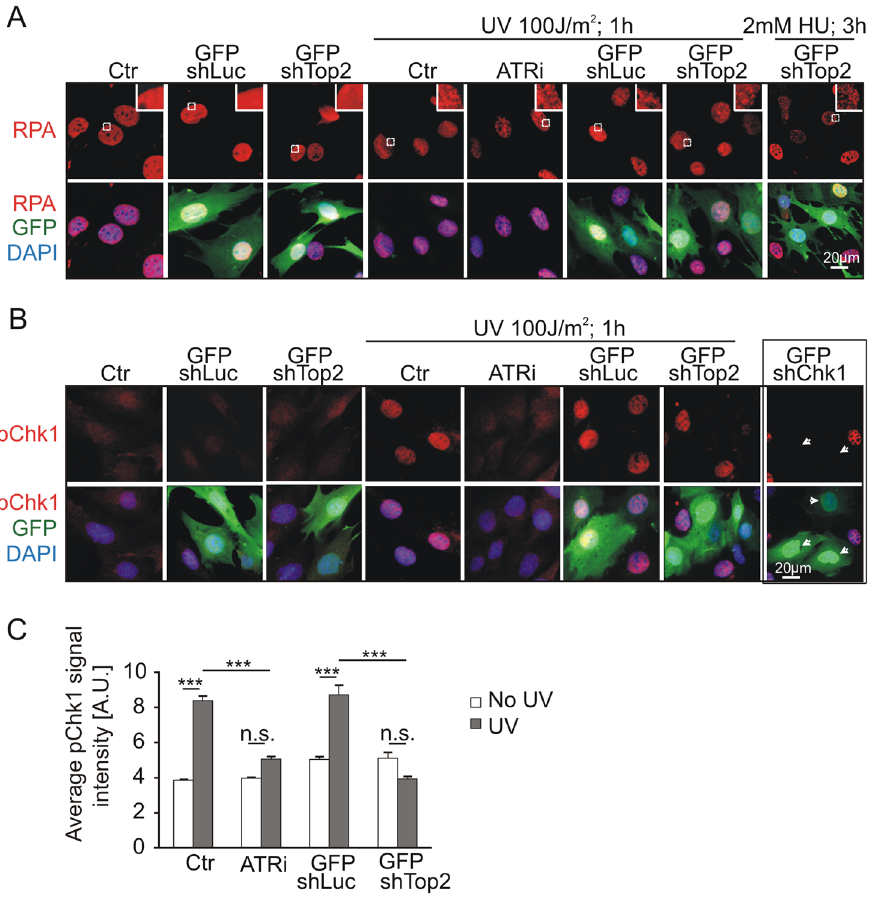
Figure 5. Mutation of AAD impairs ATR-Chk1 pathway invivo . ( A ) Immunostaining of RPA (red and upper panel) in TopBP1 ki/ + cells 36 hr after transfection with GFP-shLuc or GFP-shTop2 without or with the indicated treatment. ATRi, ATR inhibitor. GFP-shLuc or GFP-shTop2 transfection is visualized by GFP (green). DNA was stained with DAPI (blue). Inset shows the enlargement of selected areas. ( B ) Immunostaining of phosphorylation of Chk1-S317 (pChk1, red, upper panel) in TopBP1 ki/ + cells 36 hr after transfection with GFP-shLuc or GFP-shTop2 without or with the indicated treatment. ATRi, ATR inhibitor. GFP-shLuc or GFP-shTop2 transfection is visualized by GFP (green). DNA was stained with DAPI (blue). GFP-shChk1 transfection (right panel, arrows) served as a negative control for pChk1 staining. ( C ) Quantification of fluorescent density of phosphor Chk1-S317 staining (pChk1) of indicated samples from B. The data represent the mean 6 SD of at least 200 cells (or GFP positive cells) and were repeated three times. One-way ANOVA pair-test was performed for the statistical analysis. *** P , 0.001; n.s. , not significant.